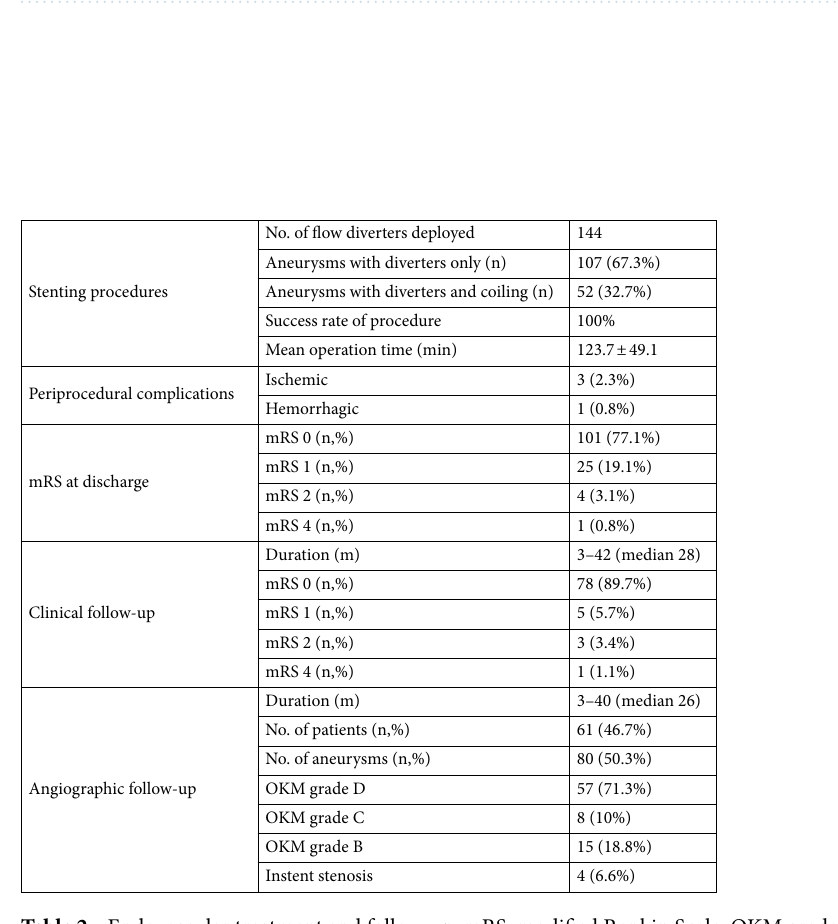
Table 2. Endovascular treatment and follow-up. mRS, modified Rankin Scale; OKM grade, O’Kelly-Marotta grading system. No significant ( P = 0.16) difference existed in the mRS at discharge compared with that at clinical